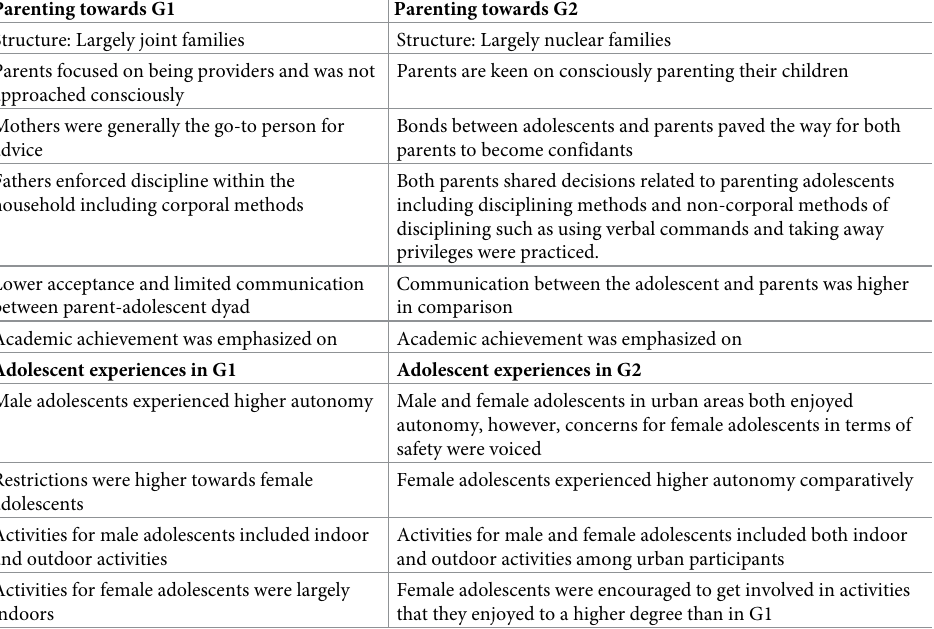
Table 3. Major findings on parenting and adolescent behaviors between generations. Parenting towards G1 Structure: Largely joint